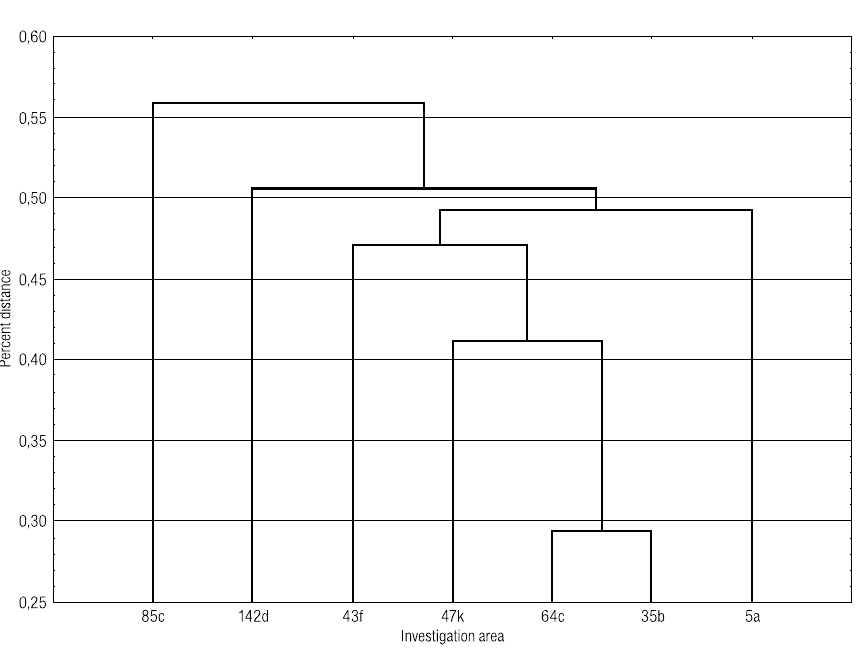
Fig. 1. Percentage distance between soil fungi community coming from compartment in Zielonka Experimental Forest